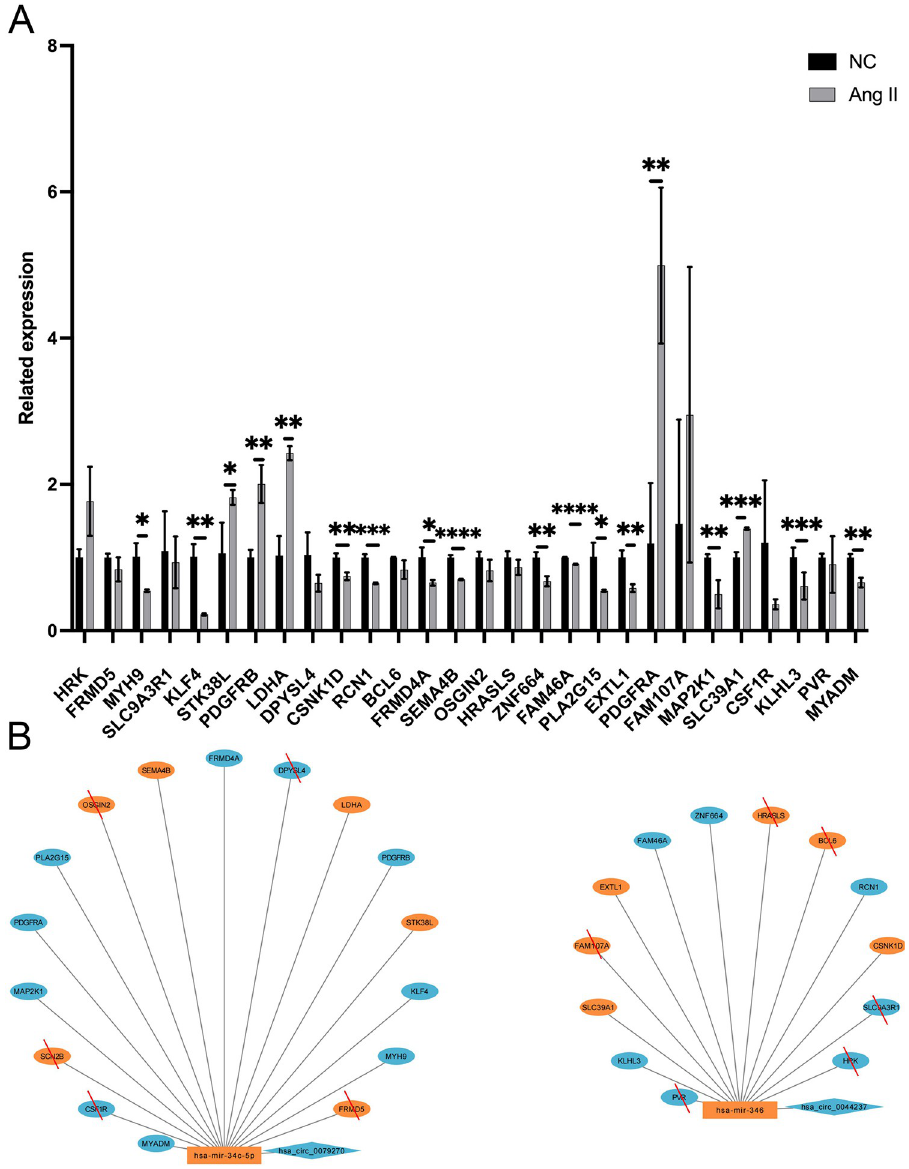
Fig 7. The RNA expression of mRNAs in the cell hypertrophy model and the modified ceRNA network diagram. A, Expression of mRNA in the cellular hypertrophy model compared to the control group. � < 0.05, �� < 0.01, ��� < 0.001, ���� < 0.0001. B, The modified ceRNA network diagram. The results marked with red lines are negative results verified by the experiment, and those not marked are positive